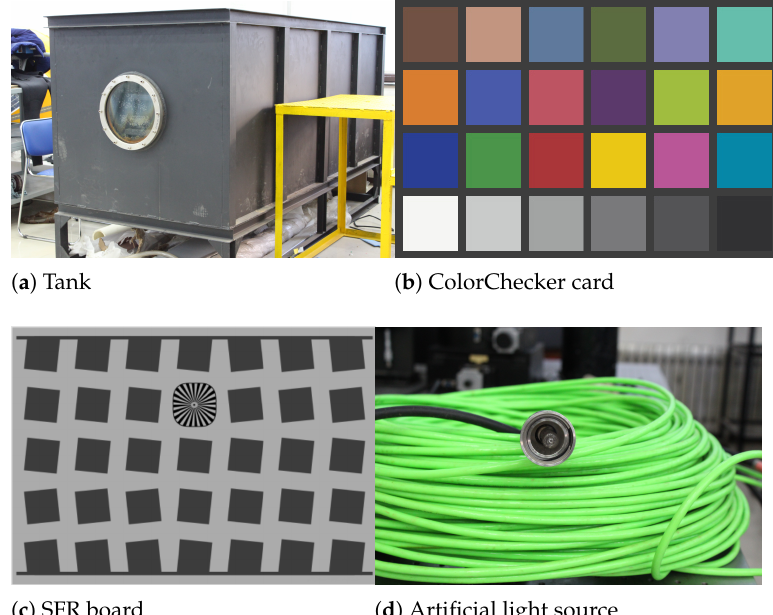
Figure 1. Experimental environment and targets.